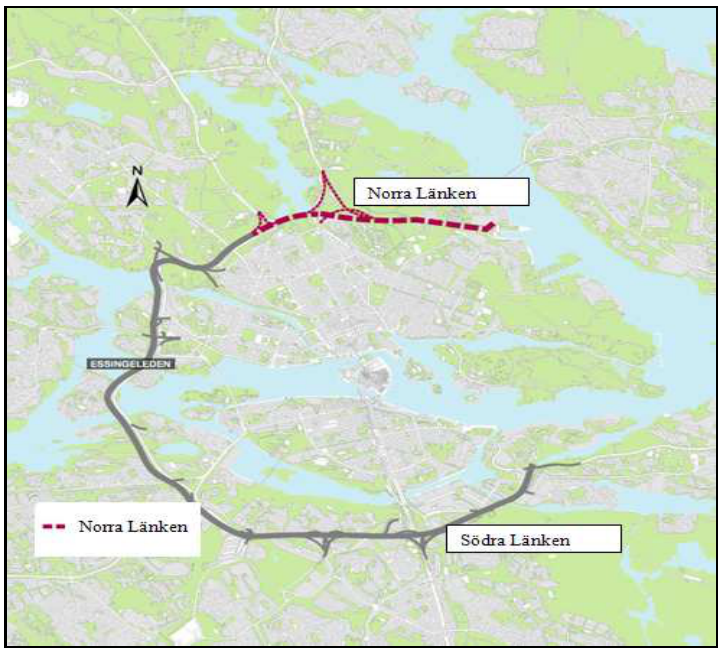
Figure 1. Map of Stockholm showing Norra Länken, part of the Stockholm ring road (Trafikverket,